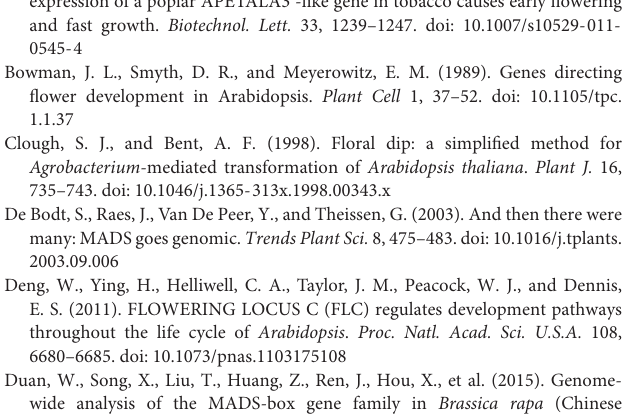
detection of the BcMAF1-GFP fusion protein in the transgenic Arabidopsis plants. The fusion protein is approximately 50 kDa. The band of marker is 50 kDa.